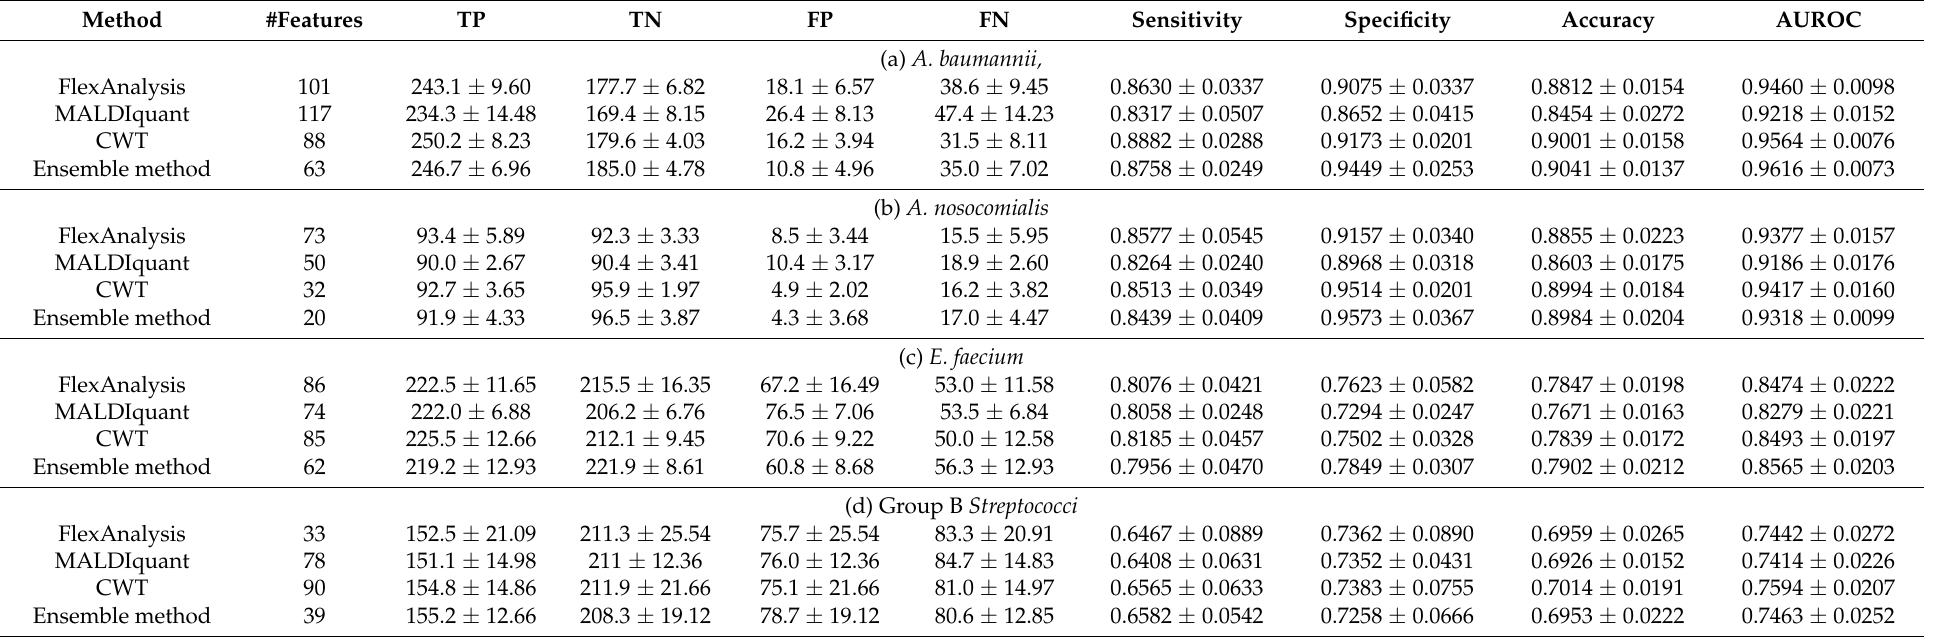
Table 1. Numbers of features for different preprocessing methods and the corresponding performance after the feature selection was adopted based on